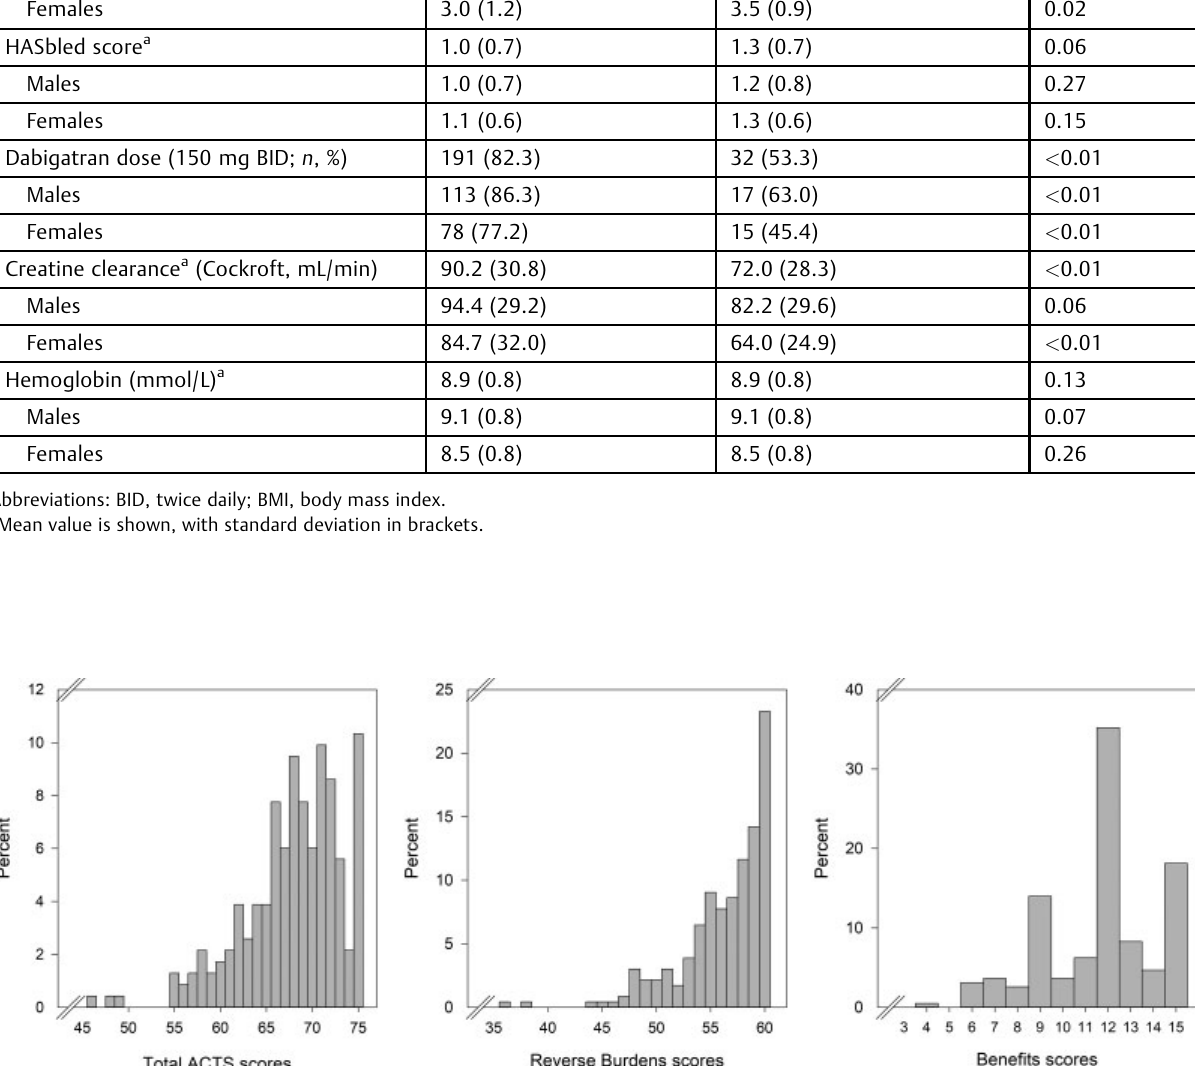
TH Open Vol. 2 No.